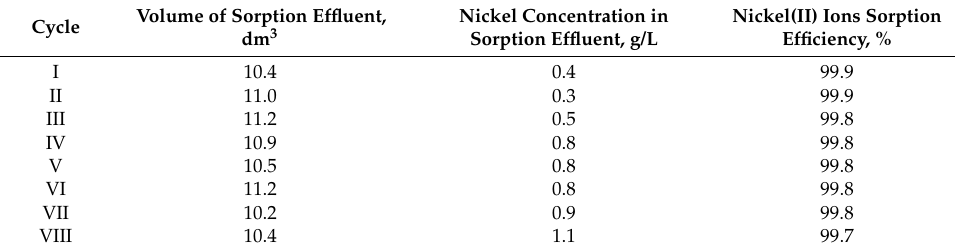
Table 2. Nickel(II) ions sorption results—eight cycles after the regeneration.